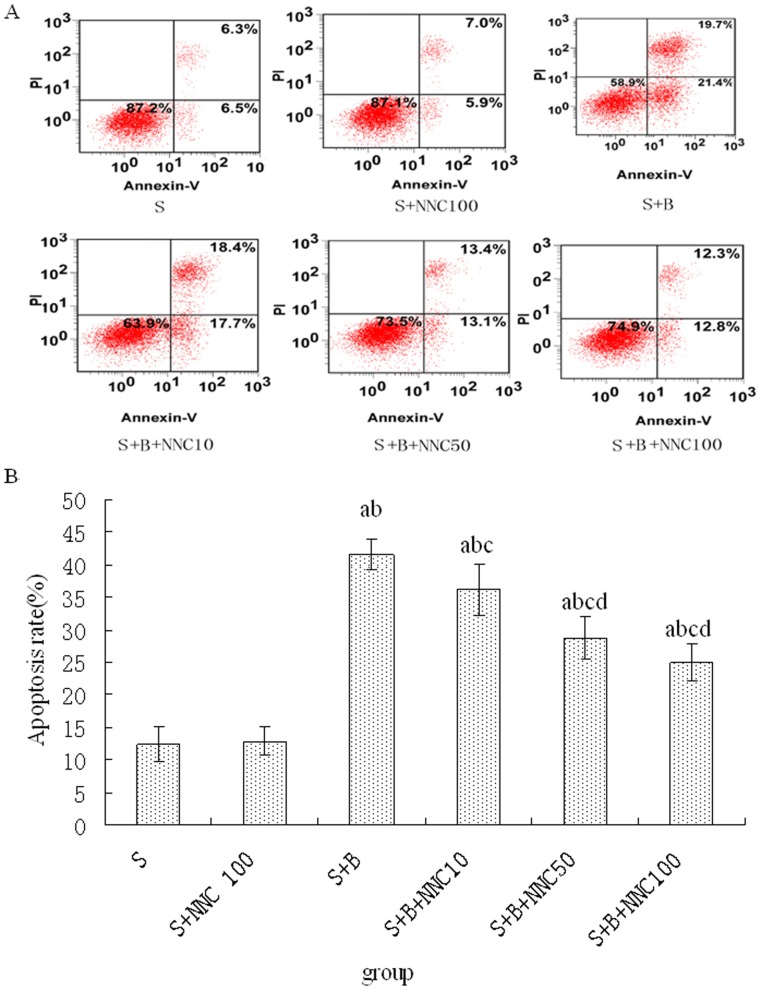
NNC 55-0396 dihydrochloride protects SH-SY5Y cells from bupivacaine-induced apoptosis.Cells were either treated with the indicated concentrations of NNC 55-0396 dihydrochloride or left untreated prior to 1 mM bupivaine treatment for 24 h. Apoptosis was measured by Annexin-V staining with flow cytometry (%, mean±SD, n = 6). A: Representative image from the flow cytometric analysis. B: Rates of apoptosis in the different treatment groups. aP<0.05 vs. S group; bP<0.05 vs. S+NNC 100 group; cP<0.05 vs. S+B group; dP<0.05 vs. S+B+NNC 10 group.